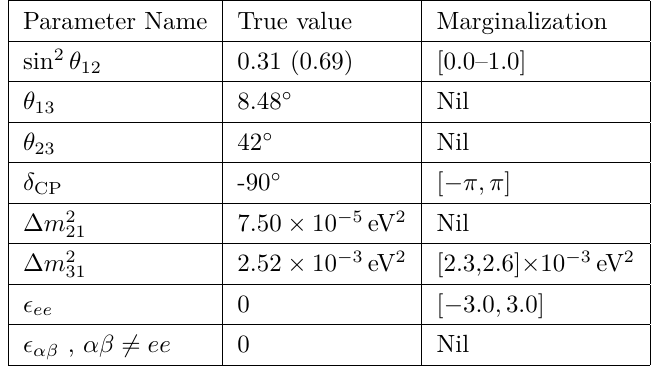
Table 1 . Values of parameters taken for generating mock data used in this work and the range over which they are marginalised in the